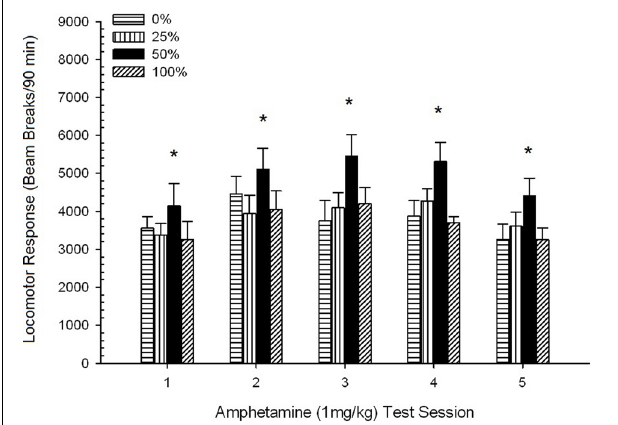
FIGURE 2 | Mean (SE) locomotor response (number of beam breaks in an electronic array per 90min) to 1mg/kg d-amphetamine (i.p.) on 5 weekly sessions in groups of Sprague Dawley rats ( n = 8/group) previously exposed to 15 daily conditioning sessions with sucrose reward (10% solution) delivered under 0, 25, 50, or 100% variable schedules. The conditioned stimulus was a light (120s). Group 0 received the same number of rewards as group 100 in the absence of conditioned stimuli. ∗ p < 0 . 05 for mean difference between group 50 and group 0 as well as group 100, based on planned